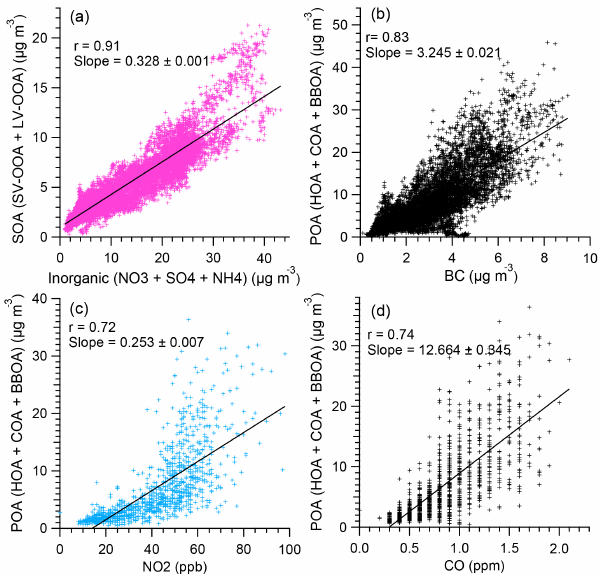
Figure 11. Scatterplot between (a) SOA and sum of inorganic (NO 3 + SO 4 + NH 4 ), (b) POA and BC, (c) POA and NO 2 , and (d) POA and CO.